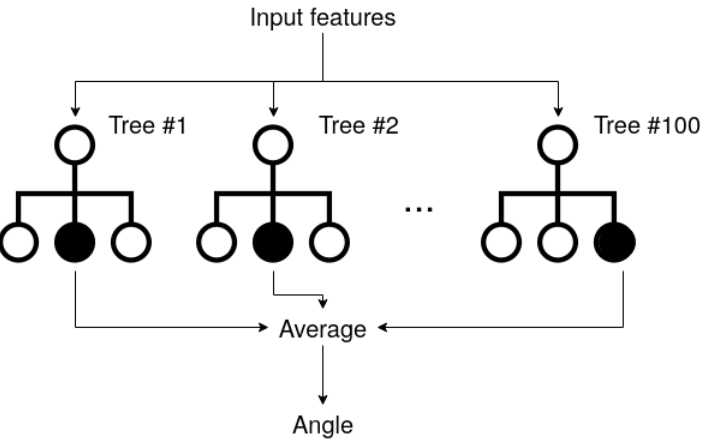
Figure 5. Random forest